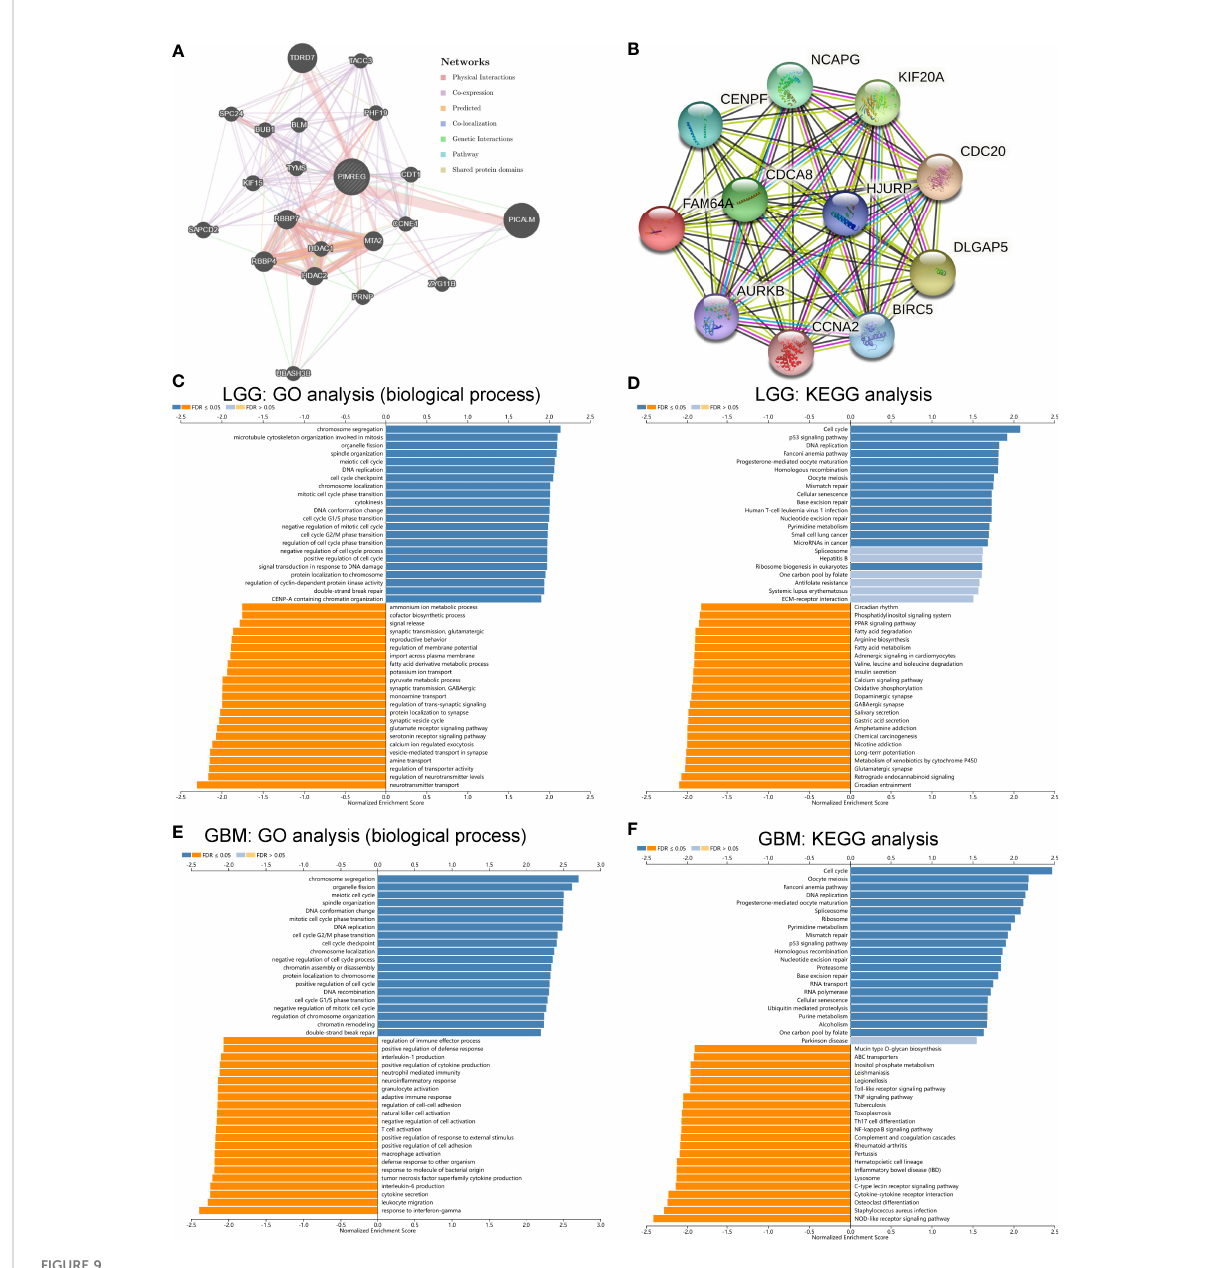
FIGURE 9 Protein – protein interaction network, GO and KEGG pathway enrichment analysis of PIMREG in glioma. PPI network of PIMREG in the GeneMINIA (A) and SRTING (B) tools. GO analysis (biological process) of PIMREG (C) and KEGG pathway enrichment analysis (D) in LGG in LinkedOmics. GO analysis (biological process) of PIMREG (E) and KEGG pathway enrichment analysis (F) in GBM in